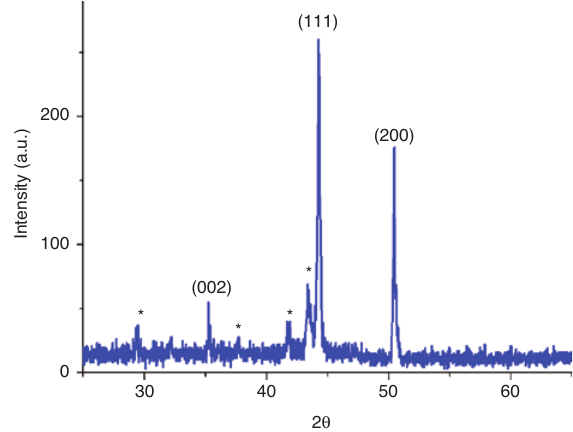
Figure 6: XRD pattern of D. erecta synthesized